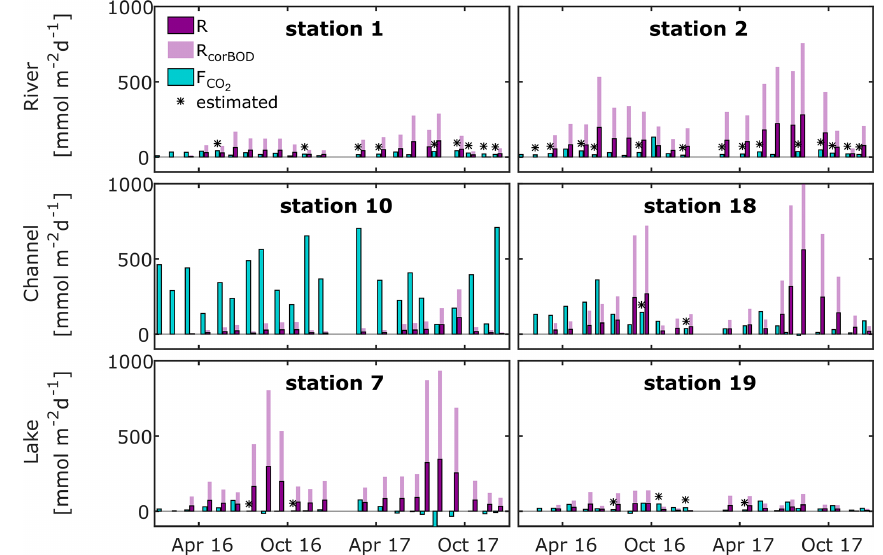
Figure 5. Flux rate and production rate of CO 2 , as calculated from O 2 community respiration incubations, for selected river, channel and lake stations. Fluxes marked with asterisks were calculated from median k 600 of our observations in the respective waterscape. Dark purple bars represent measured respiration rates; light purple bars indicate the effect of a correction for measurement limitations using BOD bottles (factor 2.7; see Ward et al., 2018).